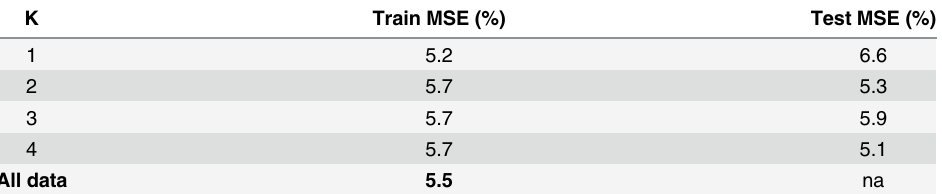
Table 4. Cross validation. MSE denotes mean square error. Training error and test error for the 5-folds of the data set. The first and third cross validation sets show slight overfit (error is higher for data not used to fit the model); the second and fourth sets show slight underfit. The overall error of 5.5% is similar to the error found at the cross validation stages. K Train MSE (%) Test MSE